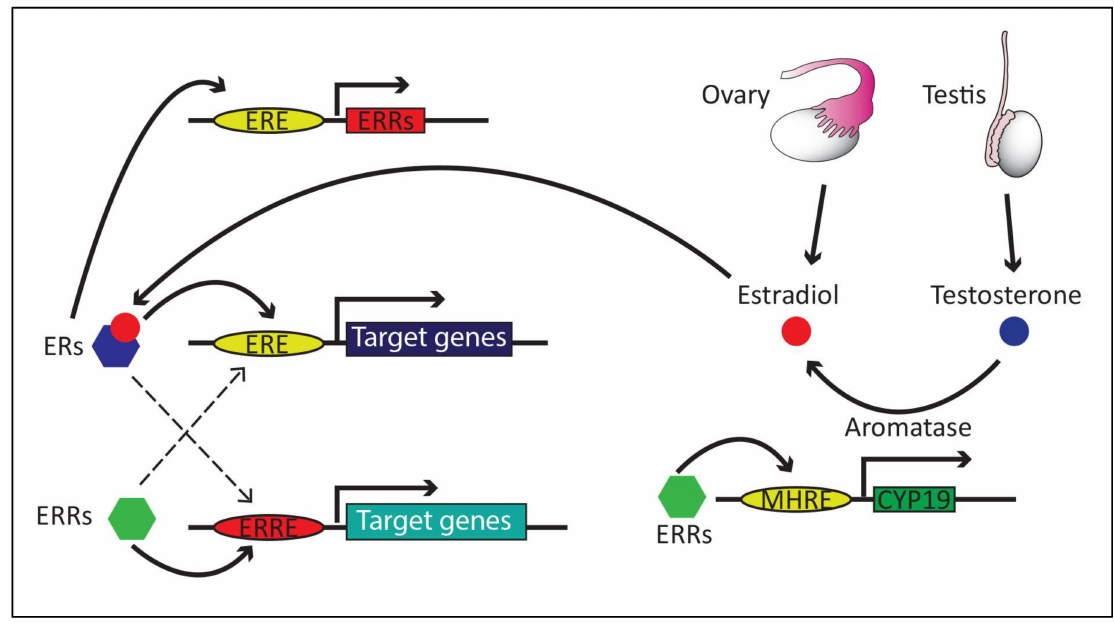
Figure 1. Schematic drawing showing potential cross-talk between estrogen, estrogen receptors (ERs), and estrogen-related receptors (ERRs). Dotted lines indicate relatively weak binding ability. MHRE, multiple-hormone response element; CYP19,